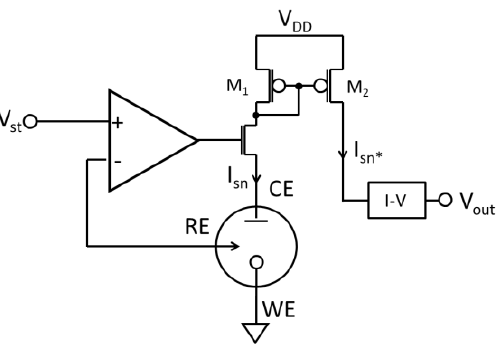
Figure 11. The structure of the current mirror amperometric readout circuit with the potentiostat (adapted from [47]).